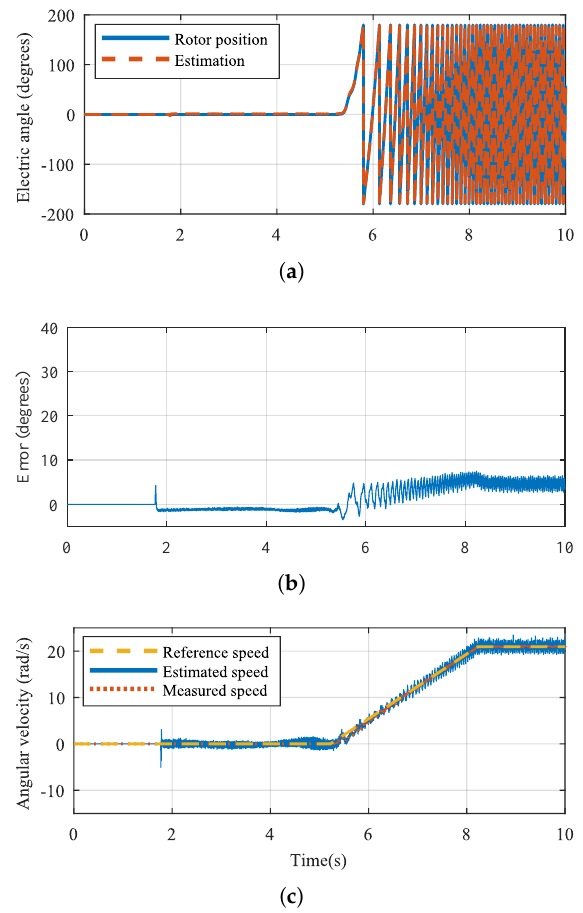
Figure 13. Experimental results using the proposed demodulation scheme. ( a ) Real (solid blue) and estimated (dashed orange) angles. ( b ) Estimation error. ( c ) Reference (dashed yellow), measured (dotted orange) and estimated (solid blue)